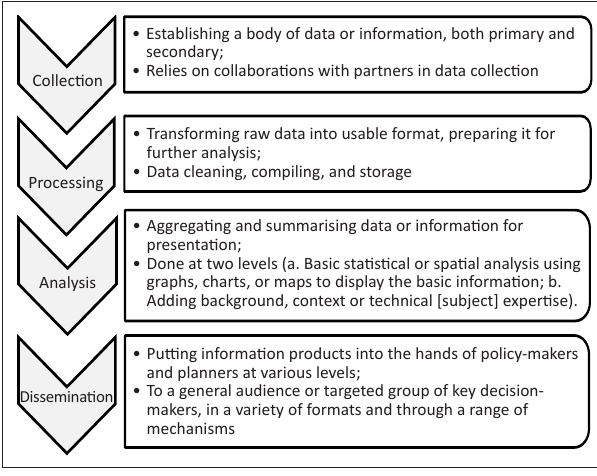
FIGURE 1: Information Management